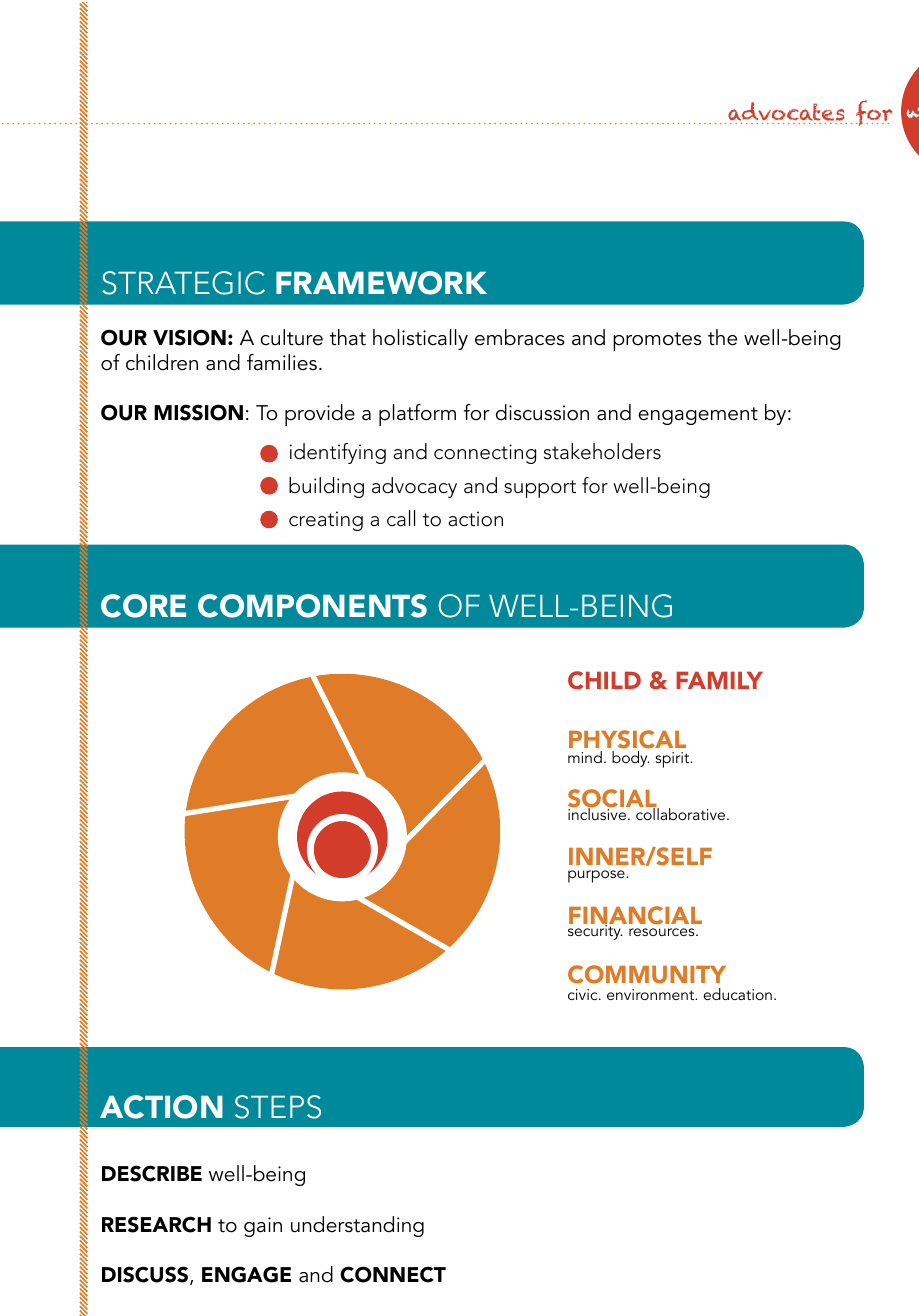
Figure A1. Advocates for Well-Being Framework with descriptors of the components of child and family